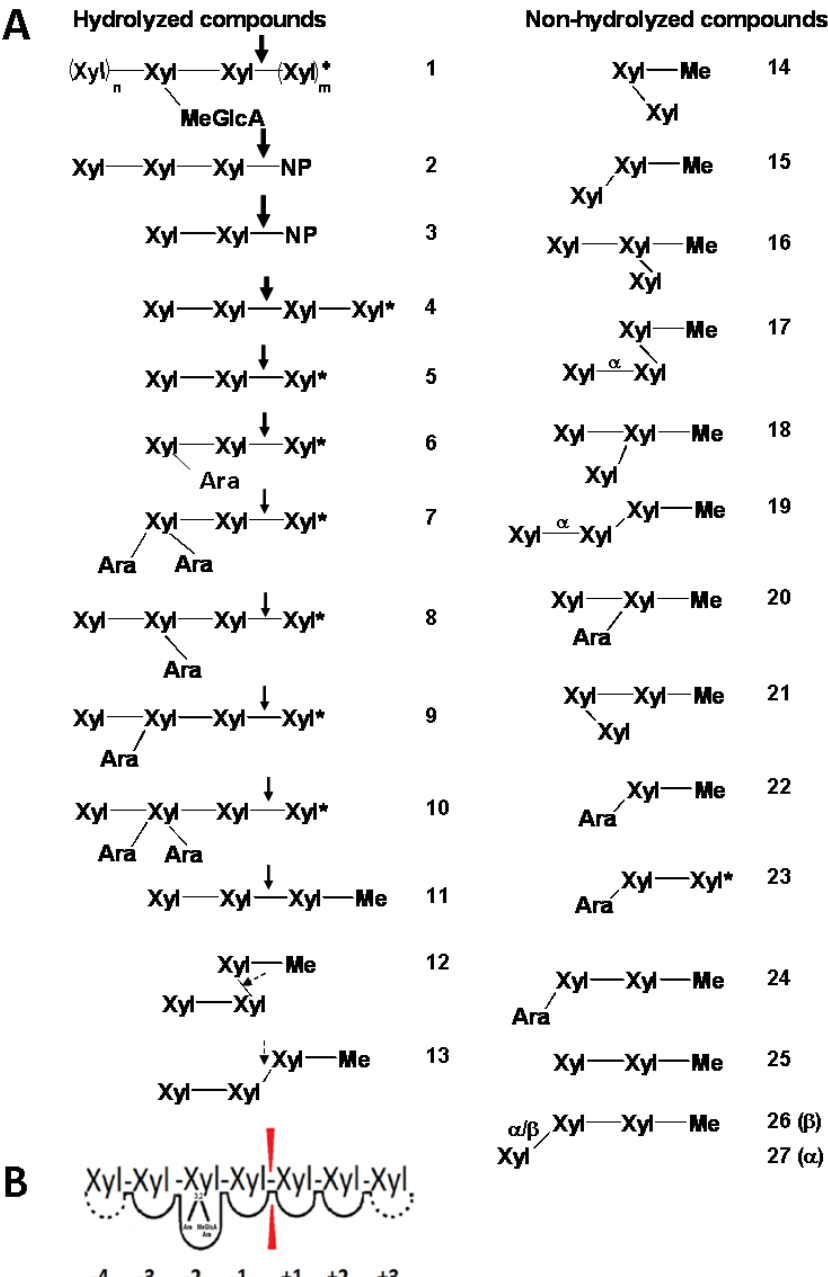
Figure 4. ( A ) The list of oligosaccharides and glycosides ( 1 – 27 ) tested as substrates for Tl Xyn30A and mode of their hydrolysis. The hydrolyzed compounds are in the left column. The arrows of different thickness mark the cleaved linkage and relative hydrolysis rates, with the best substrates on the top. The substituents linked to the xylooligosaccharide main chain with 1,2-glycosidic linkage are facing to the right (e.g., the first compound in the left column, MeGlc 3 AXyl 4 , when m, n = 1) and those linked by 1,3-glycosidic linkage are facing to the left (e.g., the ninth compound in the left column, Xyl4[Ara f 3]Xyl4Xyl4Xyl). In glycosides, the 4-nitrophenyl and methyl aglycones are abbreviated as NP and Me. The asterisks mark the reducing ends. ( B ) The scheme of the substrate binding site of the enzyme, comprising at least five subsites, indicates that the enzyme tolerates the substituents in the − 2 subsite regardless of the position of their attachment.